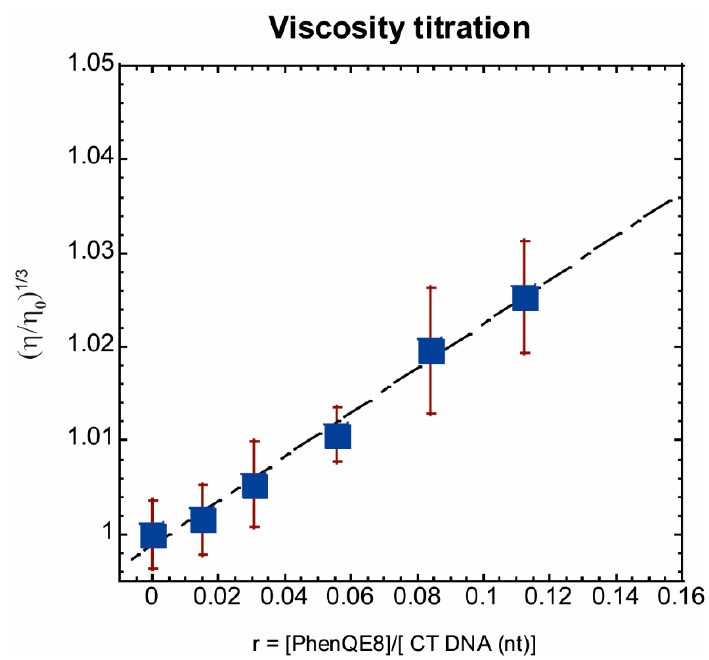
Figure 6. Viscometric titration experiment of calf thymus (CT) DNA and ligand PhenQE8 at 25 °C (10 mM sodium phosphate buffer, pH 7.2). Averaged slope value over replicate experiments is 0.24 ± 0.12.